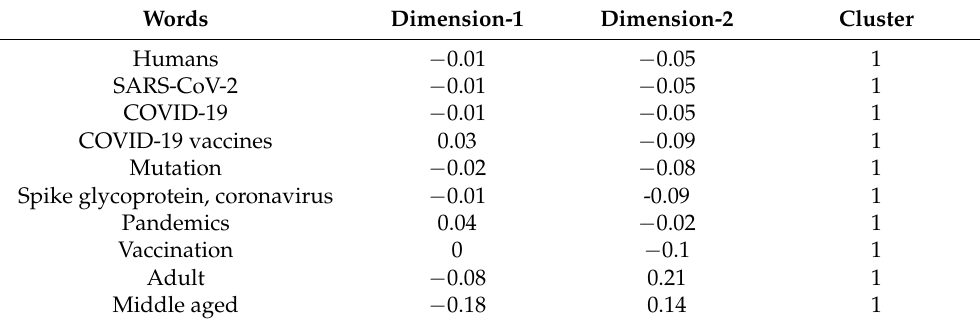
Table 7. Co-word analysis by